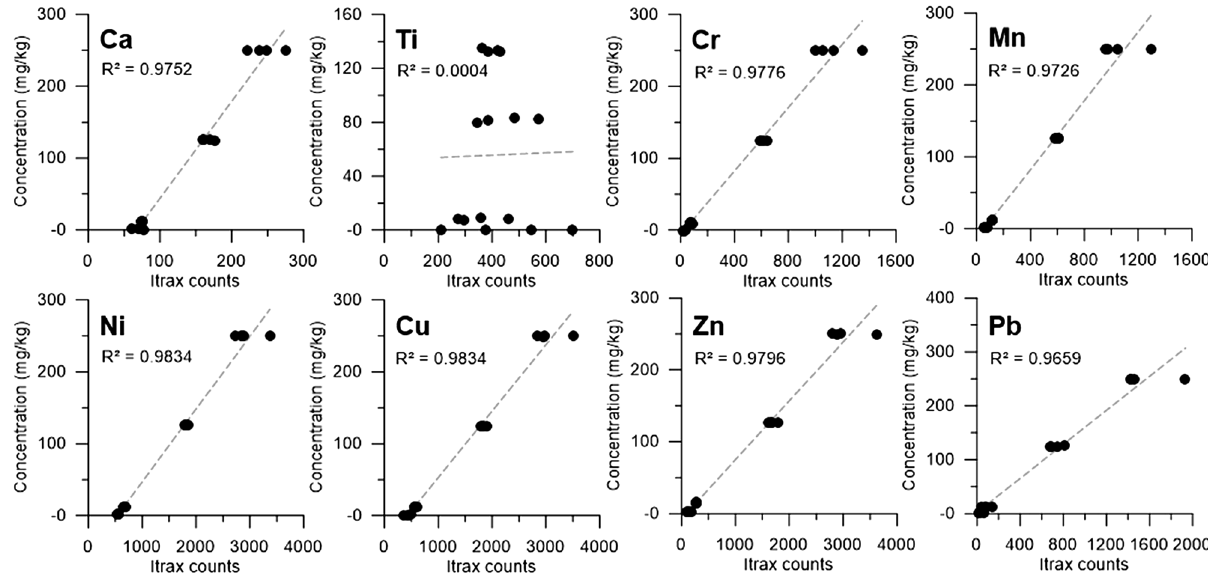
Figure 6. Cross plots for eight selected elements used to test the calibration of Itrax-CS counts to concentrations. Except for Ti, good correlations (R 2 ) above 0.96 were